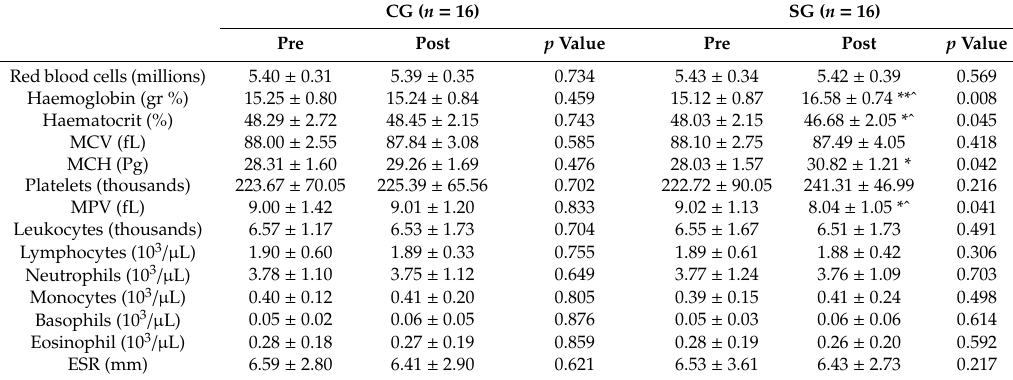
Table 9. Haemogram of both groups in the di ff erent